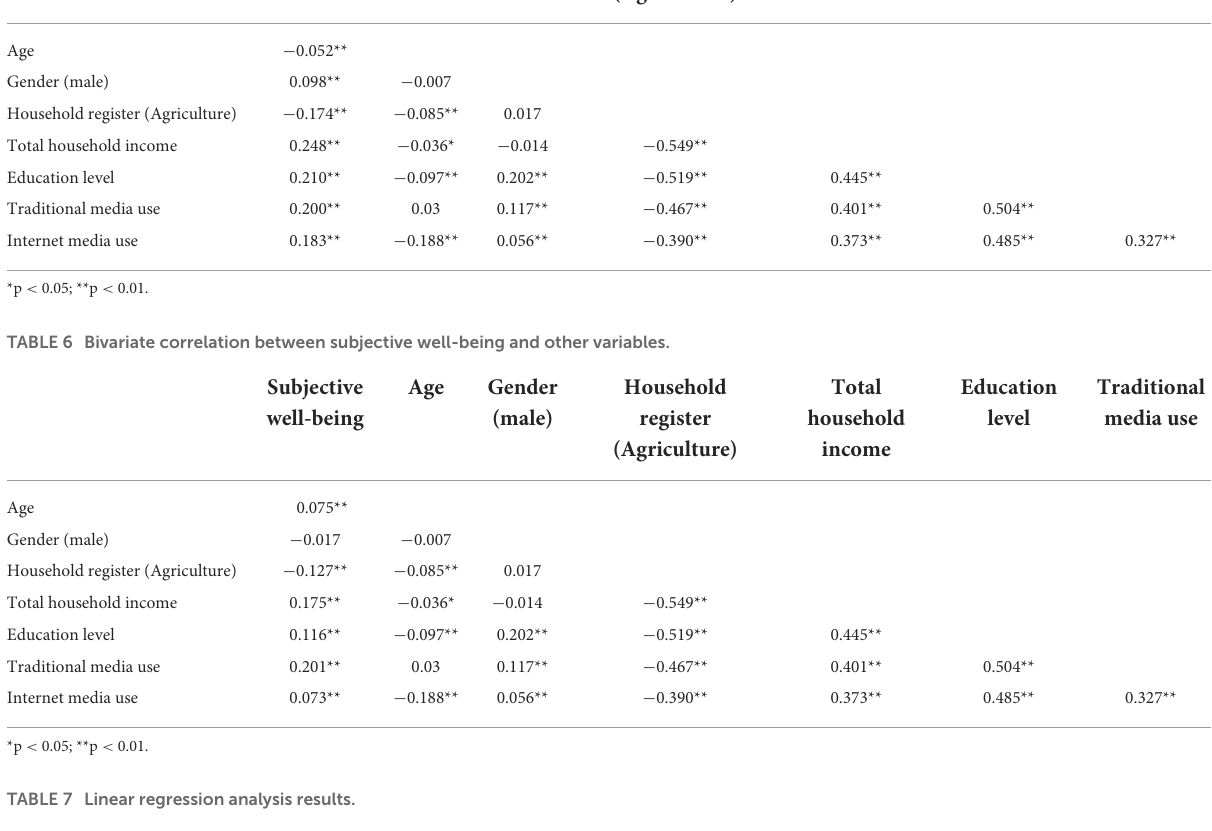
TABLE 7 Linear regression analysis